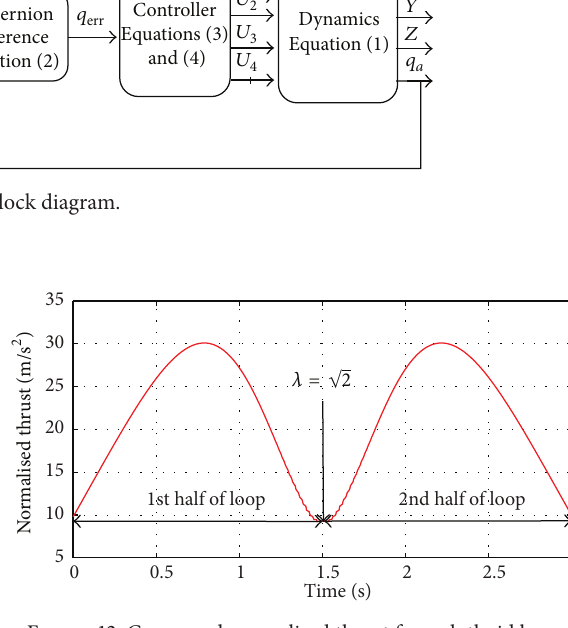
Figure 12: Command normalised thrust for a clothoid loop.